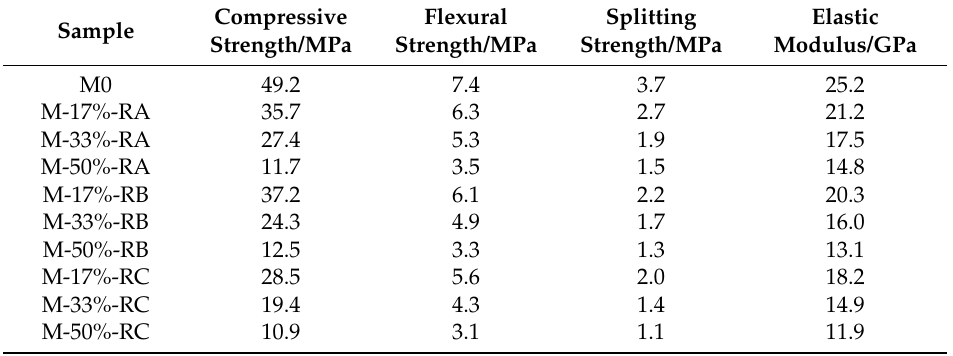
Table 5. Test results of compressive strength, flexural strength, splitting strength, and elastic modulus.